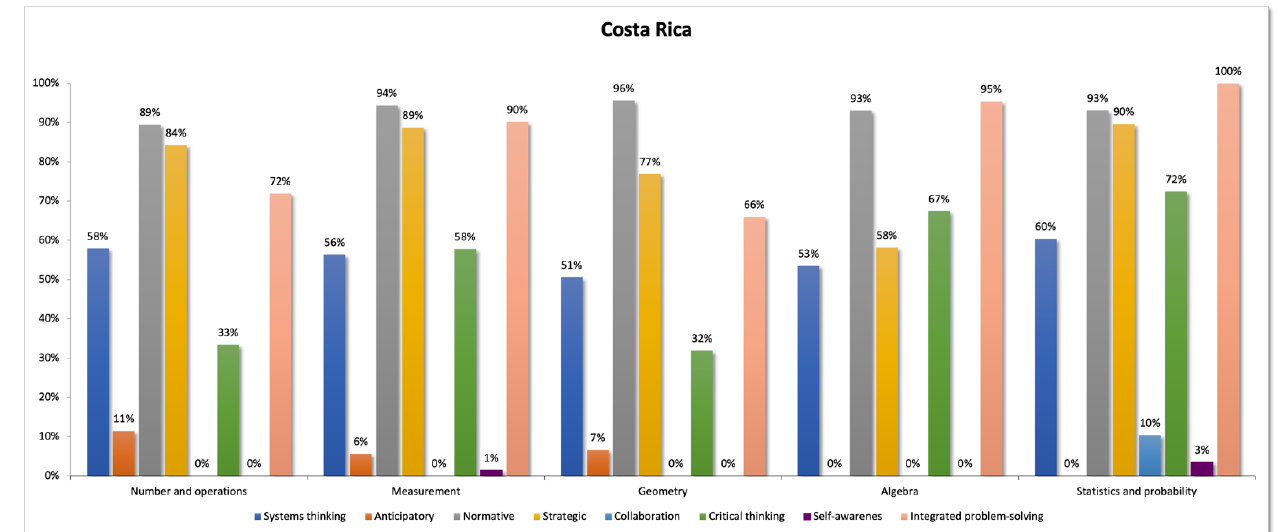
Figure 5. Sustainability competence distribution in Costa Rica according to thematic axis.